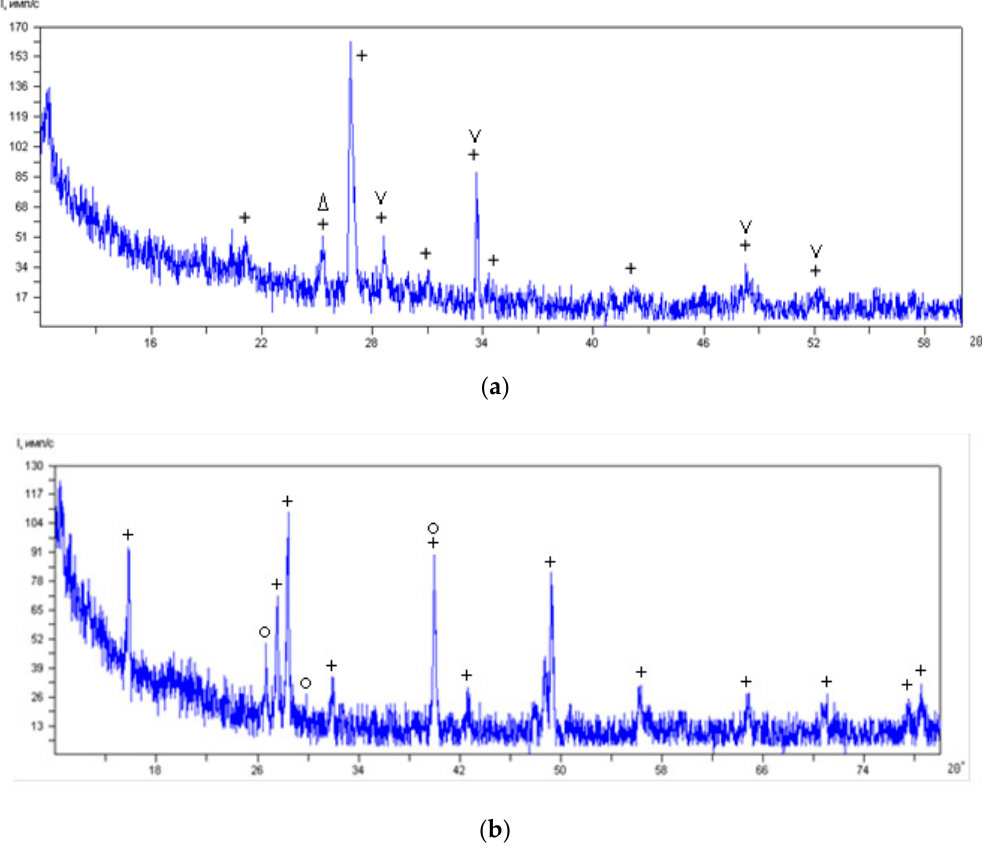
Figure 2. Diffractograms of ( a ) the initial sample of monazite concentrate; phase composition: “+” (Ce, La, Nd)PO 4 , Pr(PO 3 ) 3 ; “v” UO 2 ; “ Δ ” TiO 2 ; ( b ) the product of alkaline autoclave opening of monazite concentrate under optimal process conditions; phase composition: “+” Pr(OH) 3 , Ce(OH) 3 , Nd(OH) 3 ; “o” Ce 2 O 3 .